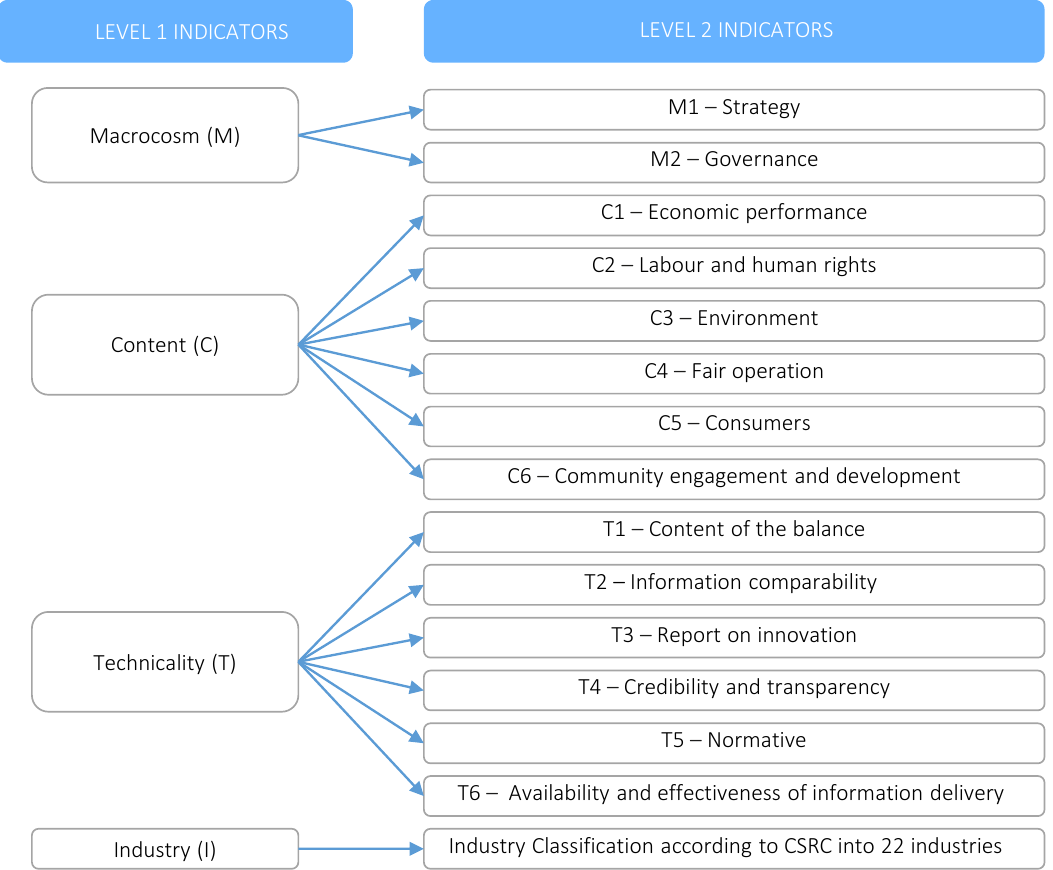
Figure 2. Indicators and sub-indicators of the RKS rating system, MCT 2012_1.2i